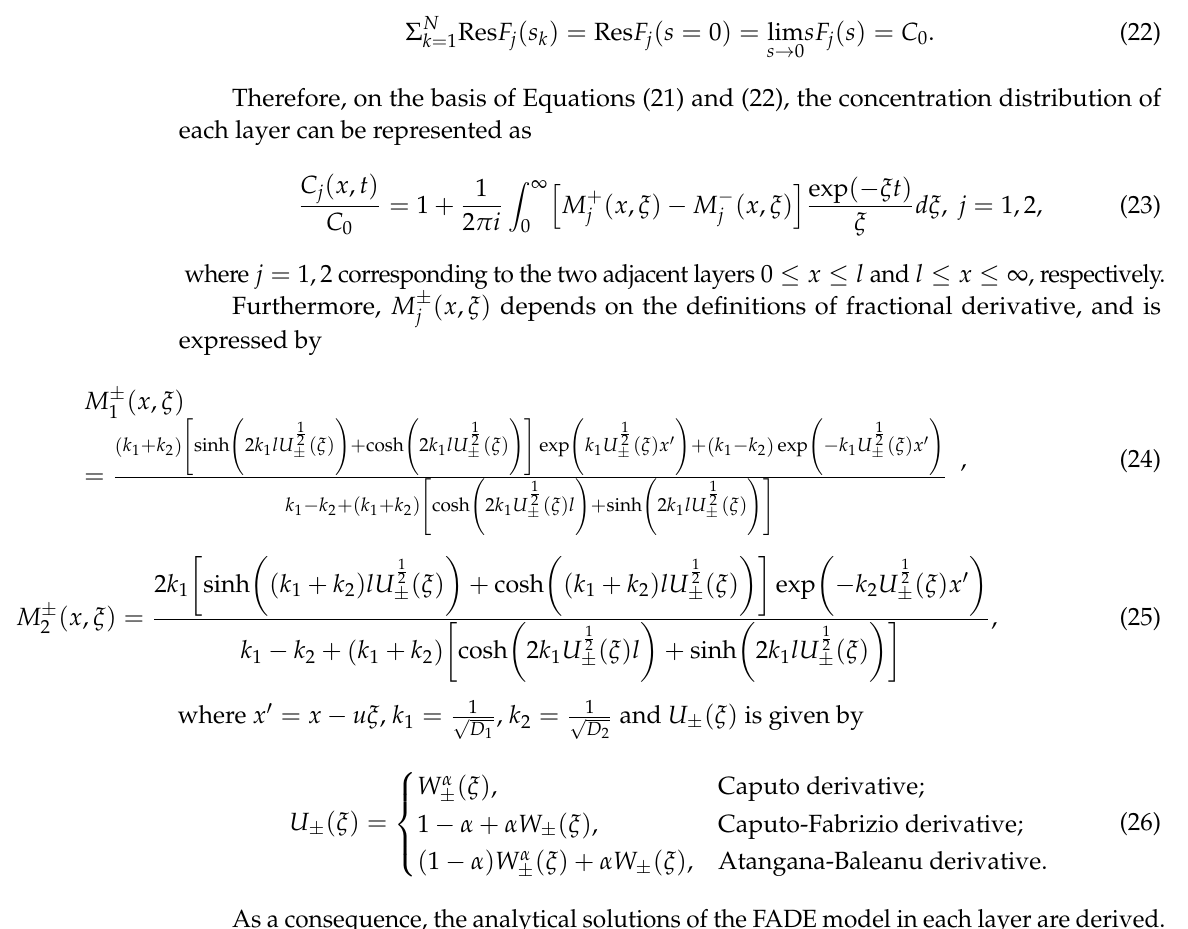
Figure 2. Bromwich–Hankel integration path